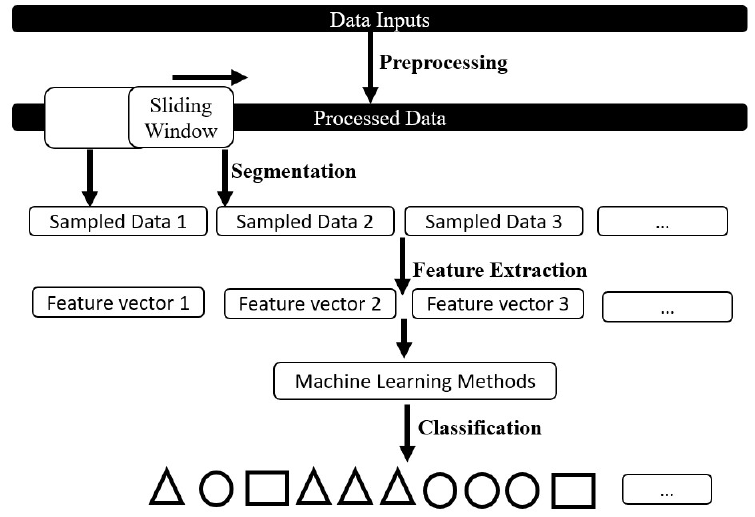
Figure 1. Overview of human activity recognition (HAR) workflow.